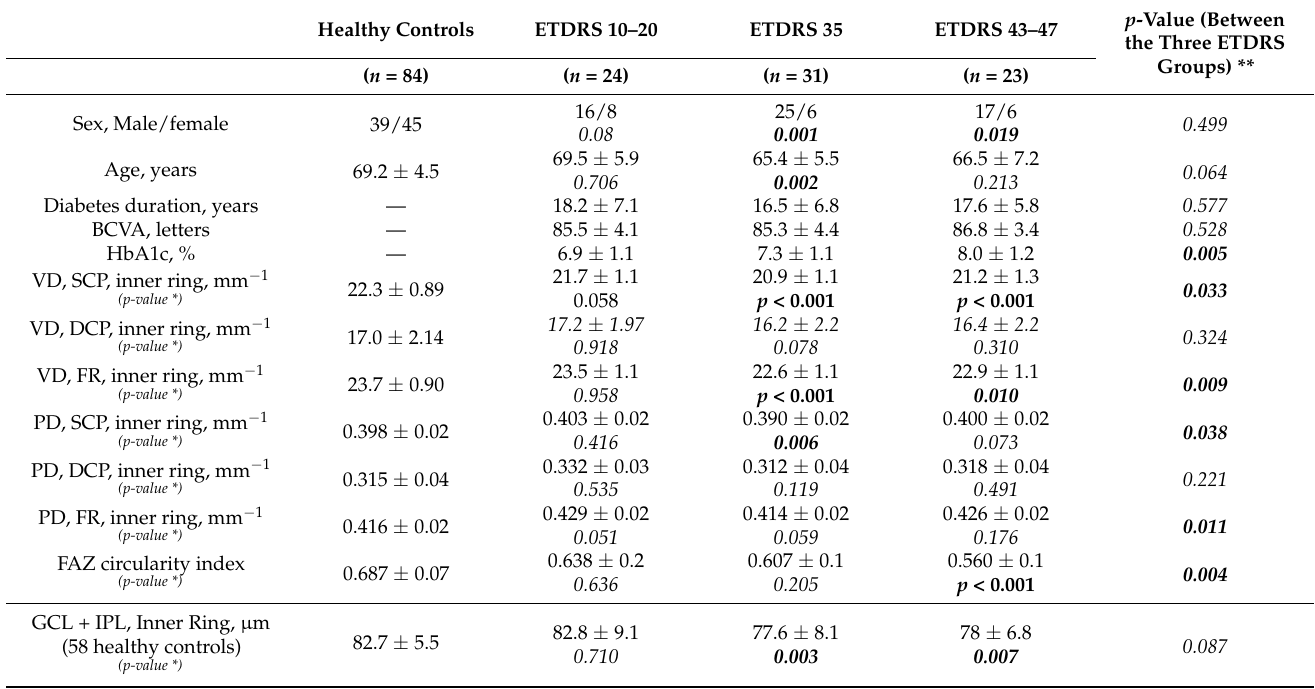
Table 1. Baseline characteristics for healthy controls and T2D individuals considering distinct DRSS stages of the disease.